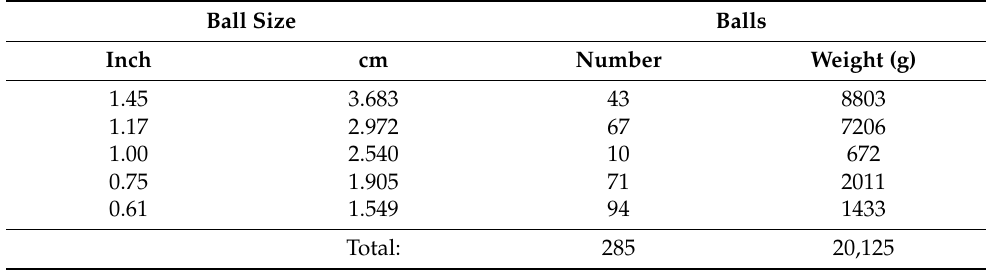
Table 1. Ball grinding charge distribution proposed by